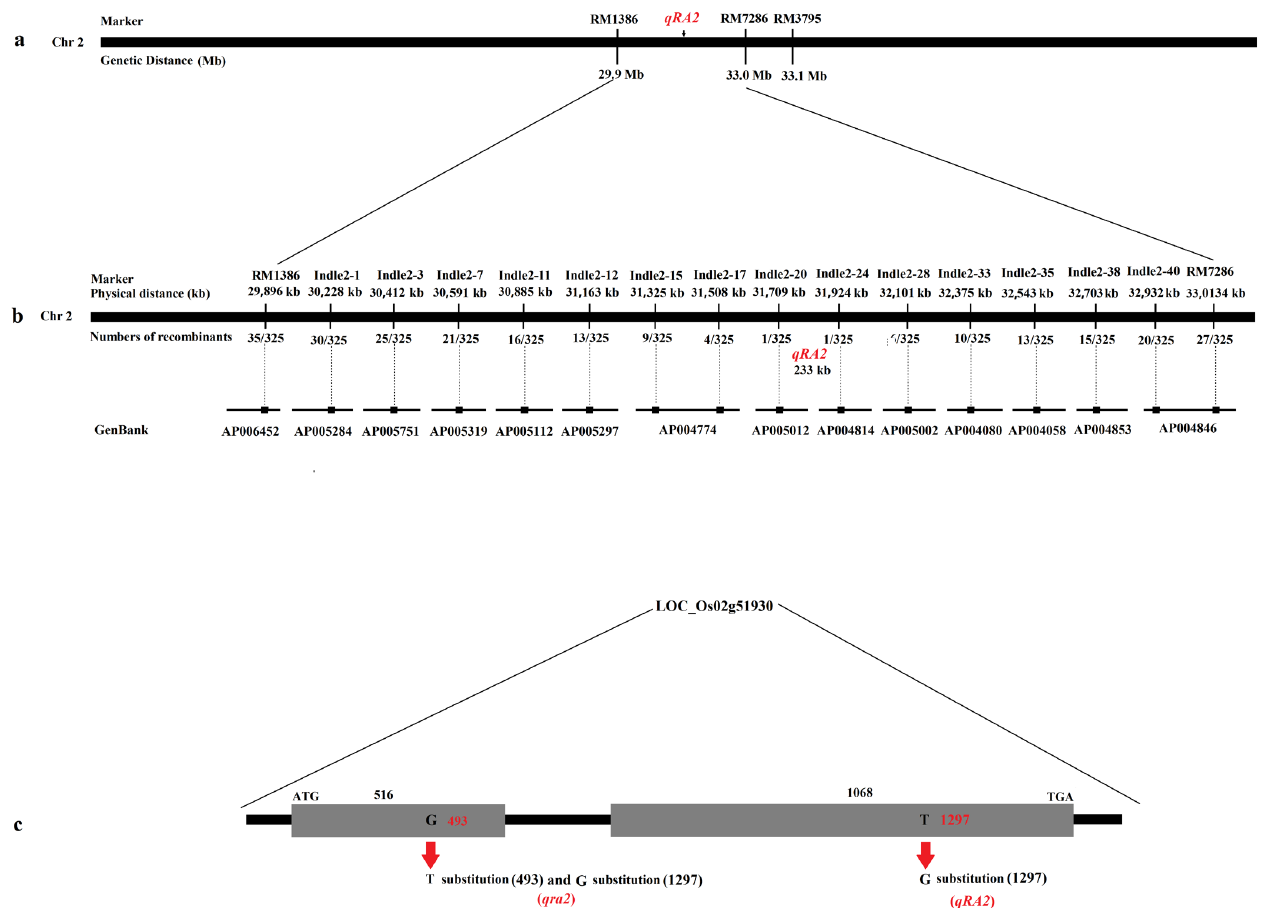
Figure 2. Physical maps and structural comparison of qRA2 . ( a ): Primary mapping of qRA2 . The QTL was mapped to the region between markers RM1386 and RM7286. ( b ): Further mapping of qRA2 , which was localized at a 233-kb region between the markers Indel2-20 and Indel2-24, and the recombinant number between the markers. In addition, the GenBack was marked below each primer marker. ( c ): qRA2 has two exons; compared with Nip, qRA2 showed a 1-bp substitution in the second exon, and qra2 showed a 1-bp substitution in the first and second exons.